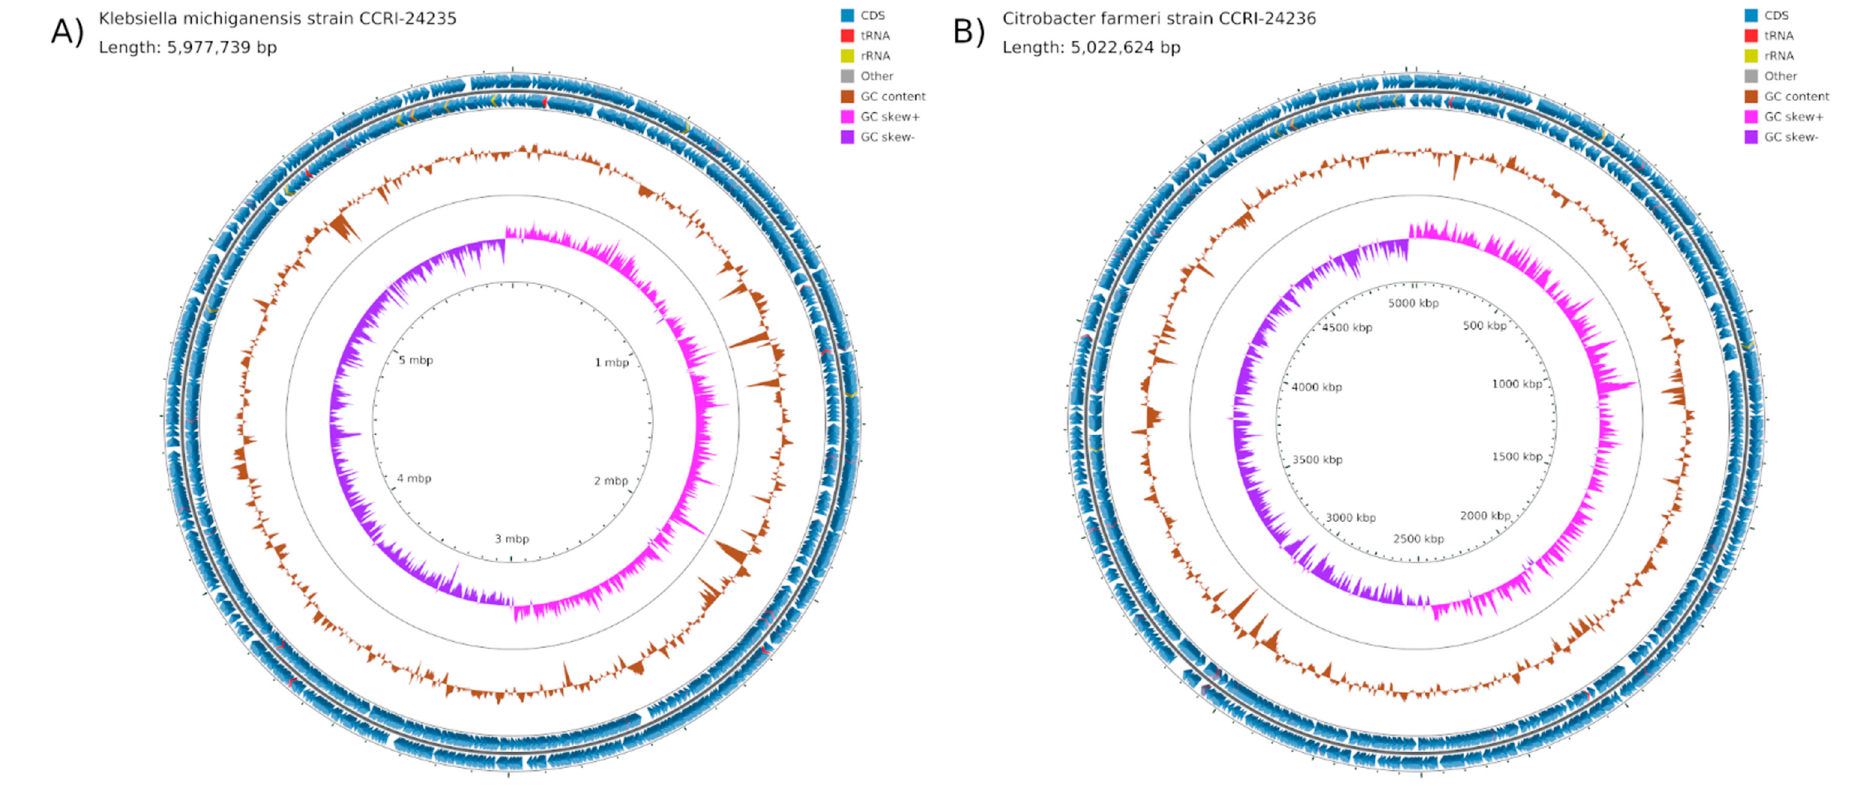
Figure 1. Map of chromosomes of K. pneumoniae CCRI-24235 ( A ) and C. farmeri 24236 ( B ). The scales are indicated on the innermost circles. The second circles are G+C skew in pink (+) and purple ( − ), and circles 3 show G+C content (deviation from the average) in brown (+, outward and − , inward). The next two circles illustrate positions of CDSs in minus (circle 4) and plus (circle 5) strands in dark blue.